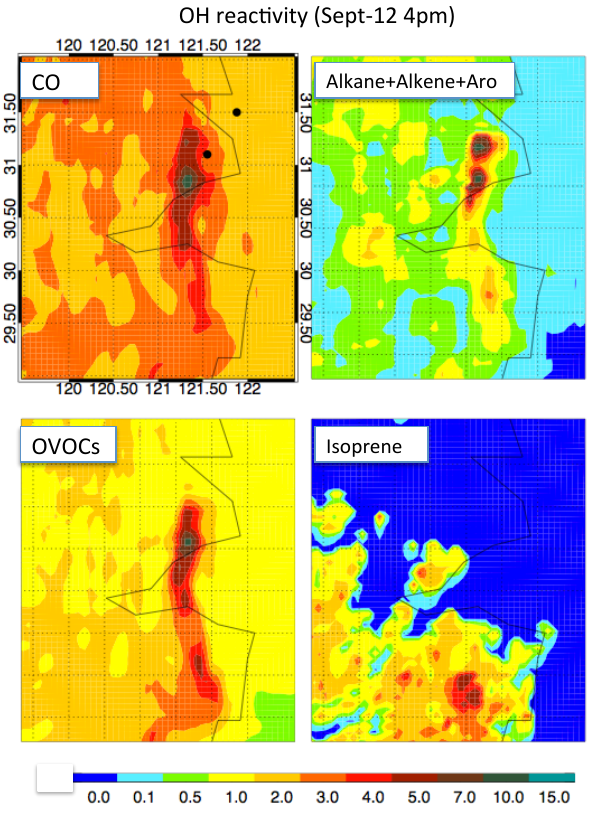
Fig. 12. The calculated OH reactivity for different species in the Shanghai region, including CO, alkane+alkene+aromatics, OVOCs, and isoprene.